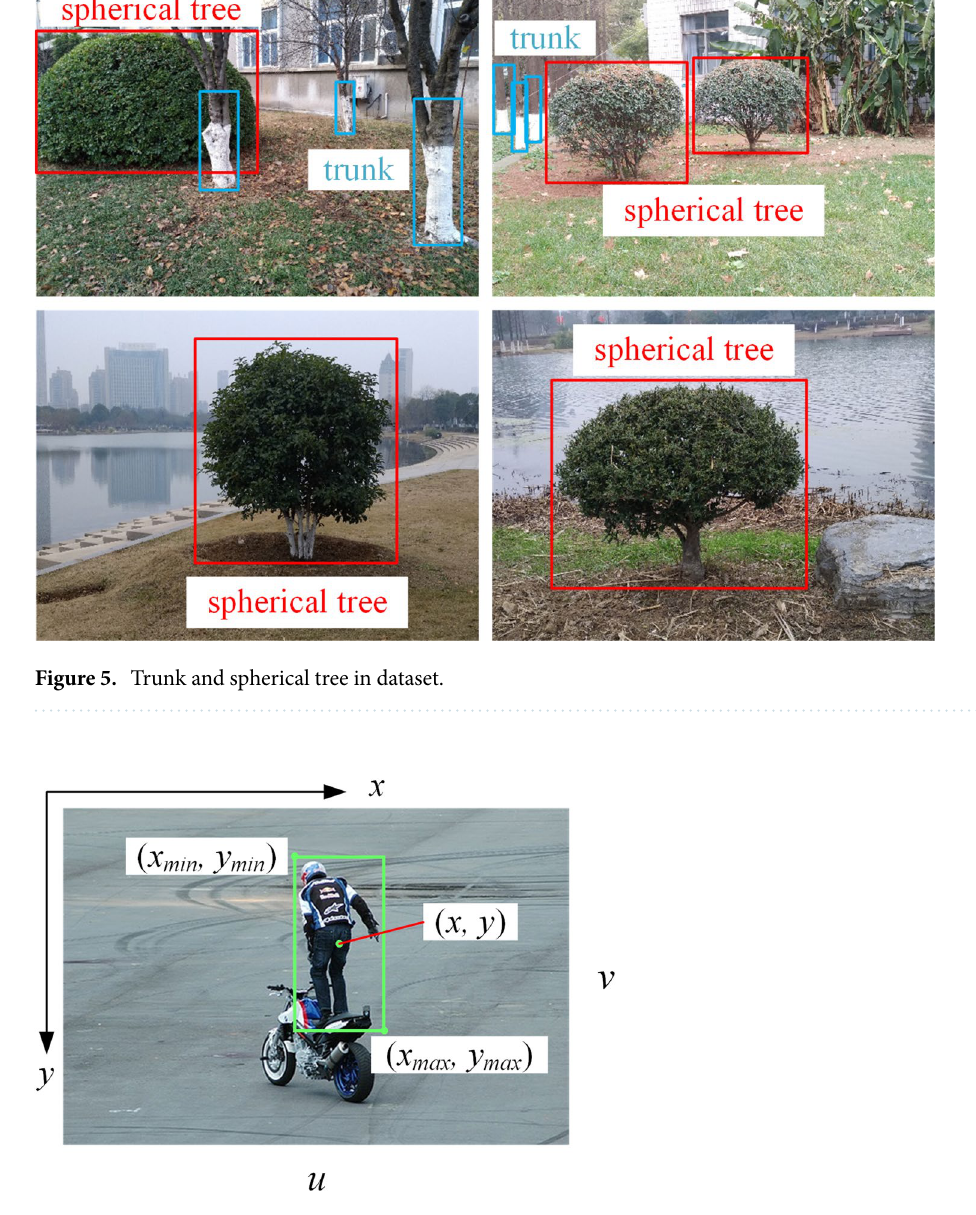
Figure 6. Annotation parameters of an object in the